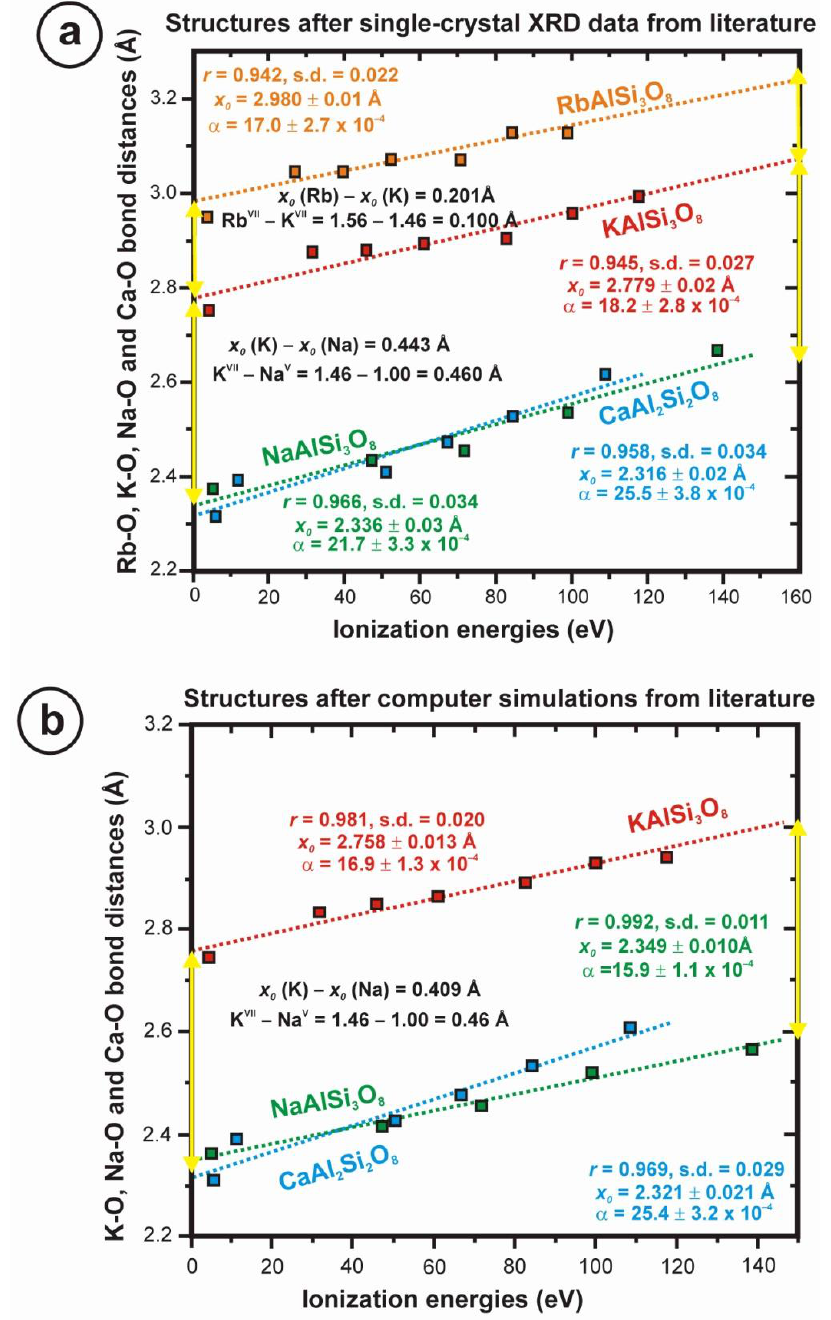
Figure 27. Relationship between the cation–oxygen distances of the cavity cations with their ioniza- tion energies, with values from [128]; ( a ) RbAlSi 3 O 8 with a C 2/ m symmetry from [129]; KAlSi 3 O 8 with low microcline C 1 symmetry from [112]; NaAlSi 3 O 8 with low albite C 1 symmetry from [130]; CaAl 2 Si 2 O 8 (An 100 from Val Pesmeda, Monzoni Mountains, Italy) with primitive anorthite P 1 sym- metry from [131]. A single curve was obtained from the average of the four sites of Ca atoms. ( b ) The same applies to structures from computer simulations in [132]. For each linear plot, we provide the r value or regression coefficient and the x 0 value; α is the line slope, and s.d. are the standard deviations. The effective ionic radii are for the expected number of oxygen atoms in the coordination polyhedron, from